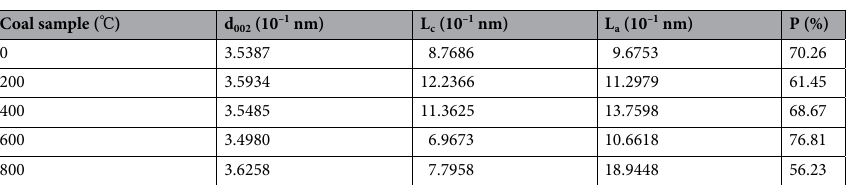
Table 3. Microcrystalline structure parameters and degree of graphitization of the coal sample with particle sizes between 0.15 and 0.18 mm at different temperatures.